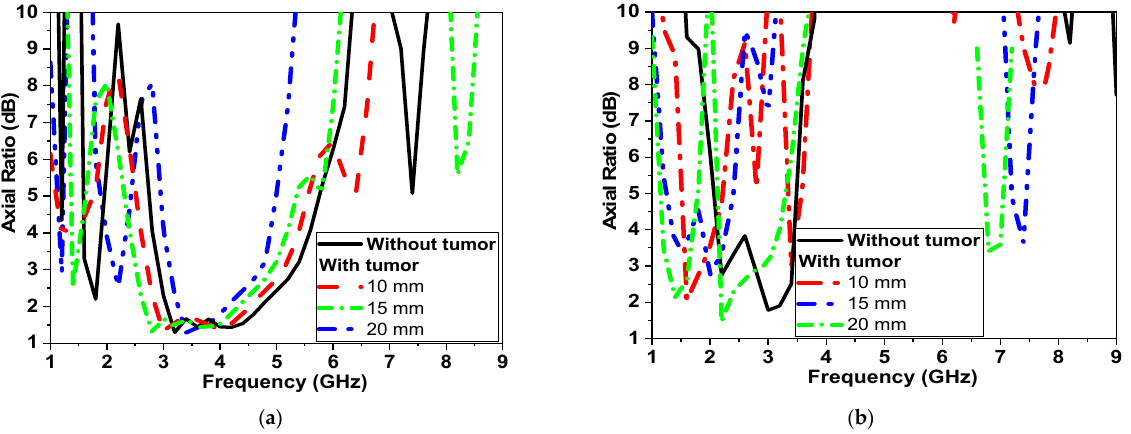
Figure 14, Simulated AR of proposed CPMS at different tumor sizes ( a ) First scenario shown in Figure 10a; ( b ) second scenario shown in Figure 10b.